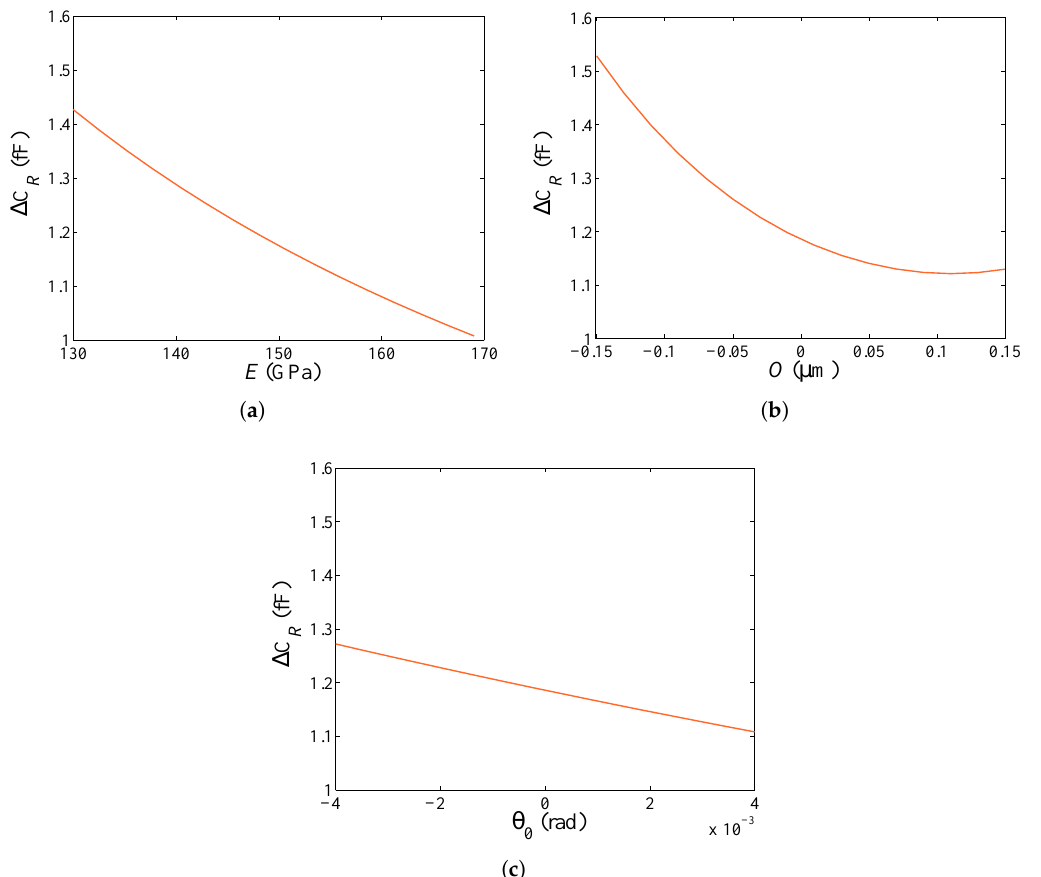
Figure 5. Rotational actuation through V R = 30 V, sensitivity of the capacitance change ∆ C R to: ( a ) E ; ( b ) O ; ( c ) θ 0